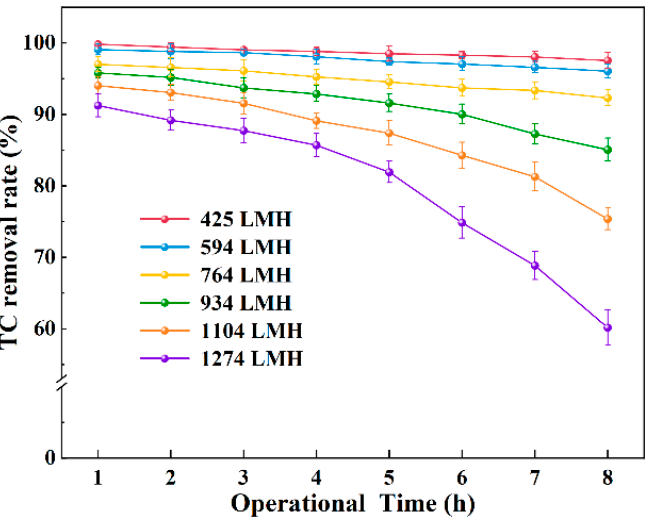
Figure 7. 8-h continuous operation performance. Experimental condition: voltage = 2 V, natural pH = 6.1, [Na 2 SO 4 ] = 0.1 mol L − 1 , [TC] = 10